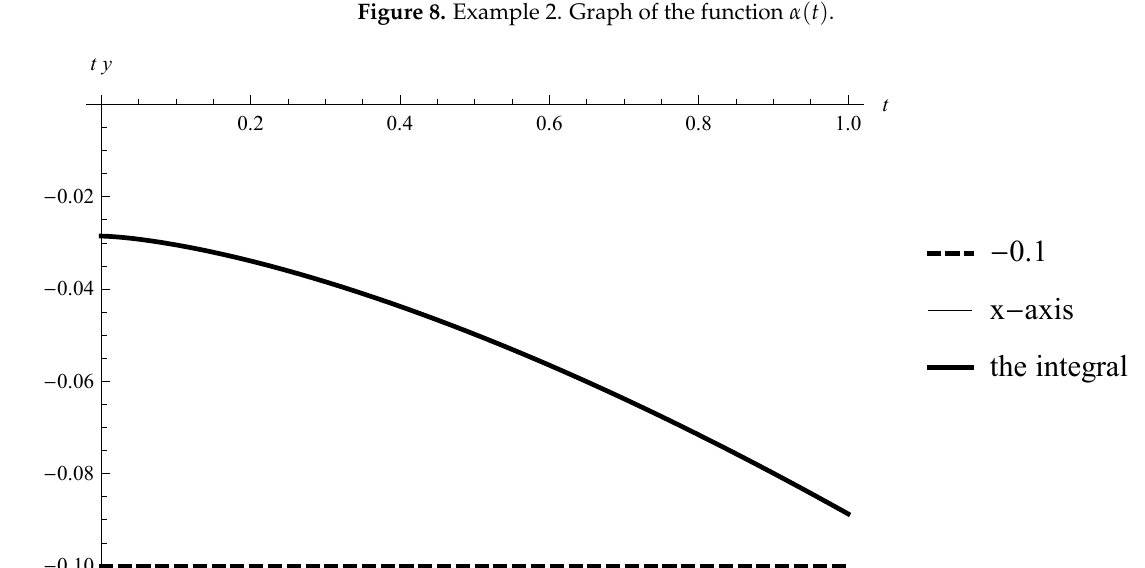
Figure 8. Example 2. Graph of the function α ( t ) .